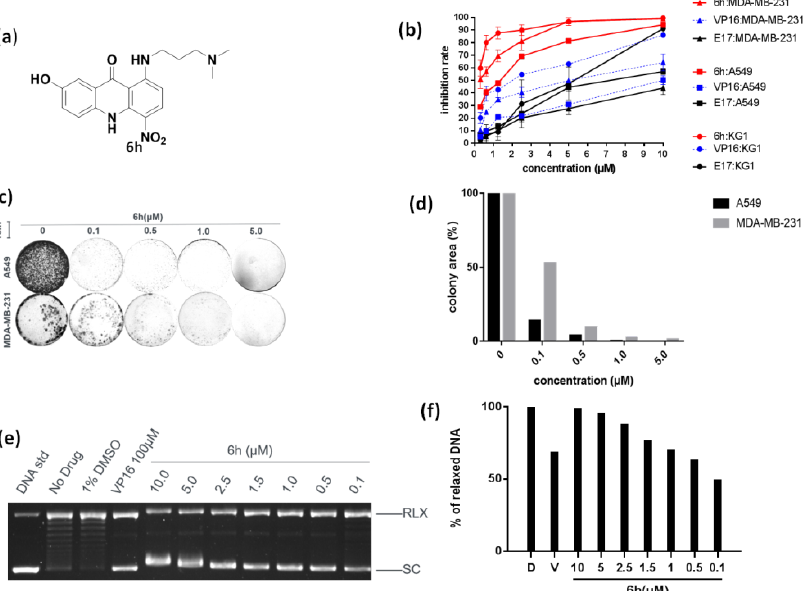
Figure 1. 6h exhibited strong anticancer efficacy by inhibiting topo II α . ( a ) Chemical structure of 6h. ( b ) 6h dose-dependently inhibited the proliferation of different cancer cells. Data are presented as mean ± SD ( n = 3). ( c , d ) 6h inhibited colony formation of two cancer cells. Images display the colony formation in 6h-treated cells. 6h dose-dependently inhibited colony formation in A549 and MDA-MB-231 cells. ( e , f ) 6h inhibited topo II α -mediated DNA relaxation. VP16 was set as a positive control. Supercoiled pBR322 DNA (SC) and relaxed DNA (RLX) are shown. D: DMSO, V: VP16 at 100 µ